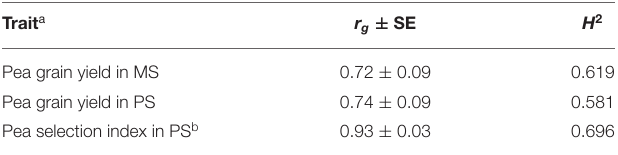
TABLE 5 | Genetic correlation ( r g ) across two cropping years and broad-sense heritability over years on a line mean basis ( H 2 ) of pea yield in mixed stand with cereals (MS) and pea yield or a pea selection index in pure stand (PS), for 144 pea inbred lines across two cropping